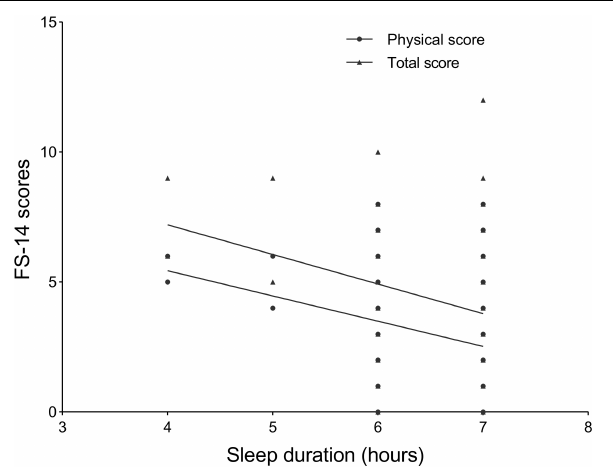
FIGURE 2 | The negative correlation of sleep duration with the 14-item Fatigue Scale (FS-14) physical score ( r = –0.319, p = 0.001) and FS-14 total score ( r = –0.315, p = 0.001) in group of sleep before 23 o’clock of short sleep duration.